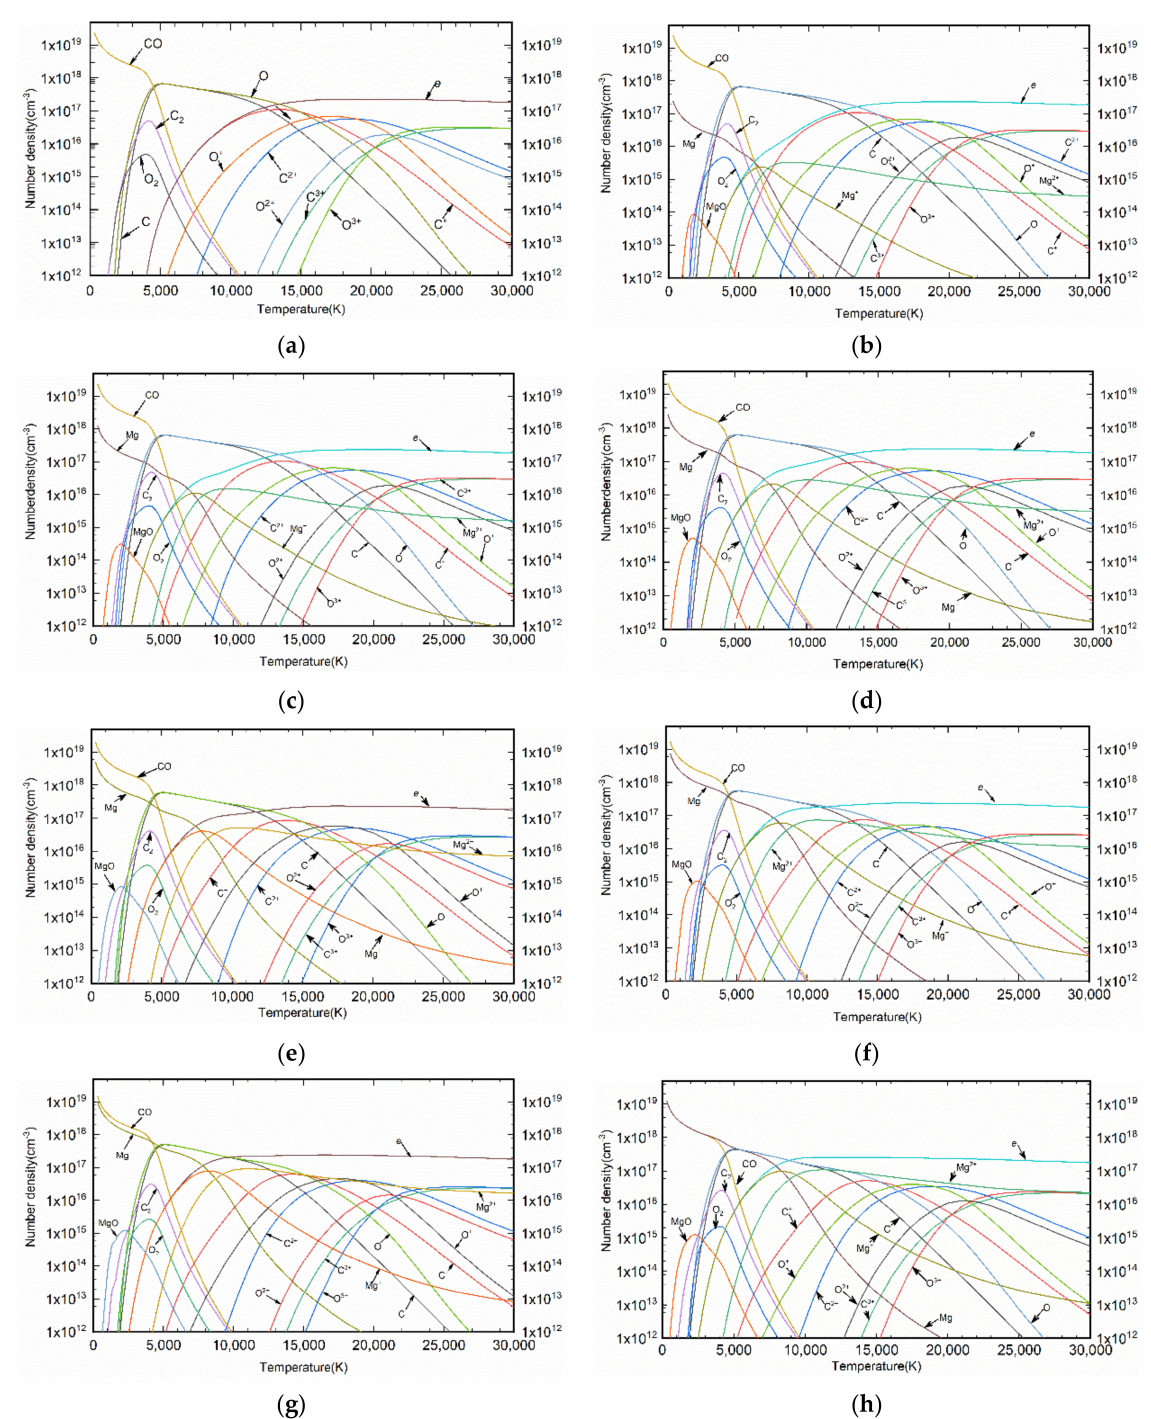
Figure 6. Equilibrium compositions of Mg-CO mixture plasma at temperatures of 300–3000K and a pressure of 0.1 MPa. ( a ) CO100% ( b ) Mg1%-CO99% ( c ) Mg5%-CO95% ( d ) Mg10%-CO90% ( e ) Mg20%-CO80% ( f ) Mg30%-CO70% ( g ) Mg40%-CO60% ( h )